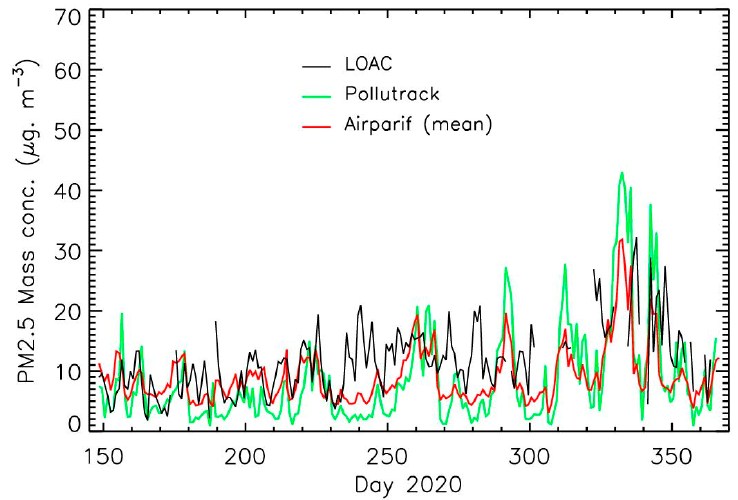
Figure 4. Temporal evolution of the PM2.5 mass concentration at the “Ballon de Paris Generali (LOAC and Pollutrack) with mean value of the microbalances of the Airparif network in the south of Paris and its region.